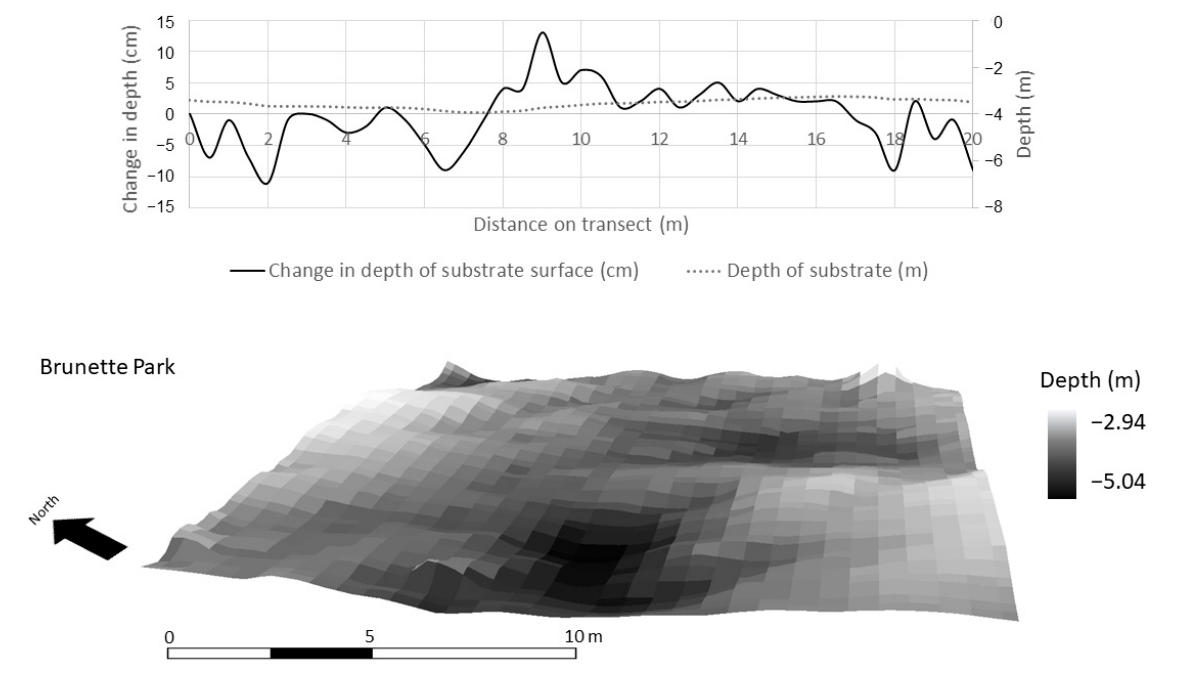
Figure 8. High resolution bathymetry (0.3 m) collected by an autonomous underwater vehicle in Lake Superior in a randomly selected 20 m × 20 m plot at Brunette Park. Depth profile ( top ) and area ( bottom ) documenting the microtopography of periphyton habitat.